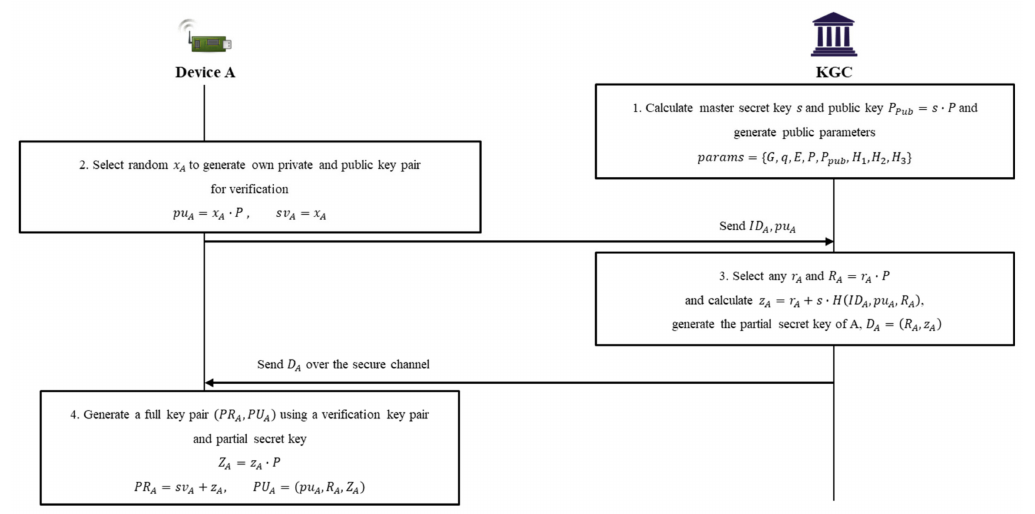
Figure 5. Sequence diagram of setup